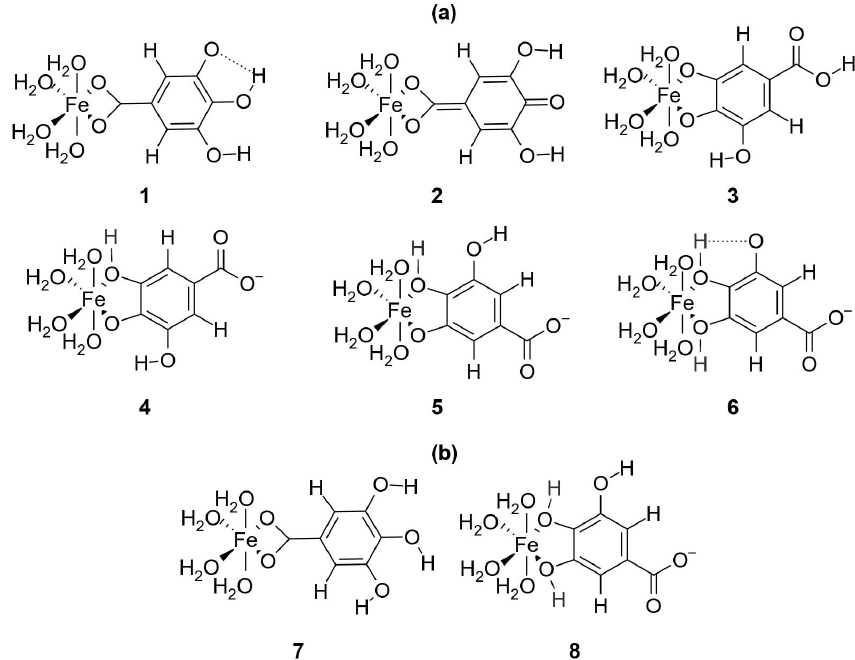
Figure 9. Chemical structures of all proposed coordination complexes between iron ions and gallic acid anion ( a ) or monoanion ( b ), which were considered in the DFT calculations. The numbering below the coordination compounds is used in the main text to refer to these complexes.